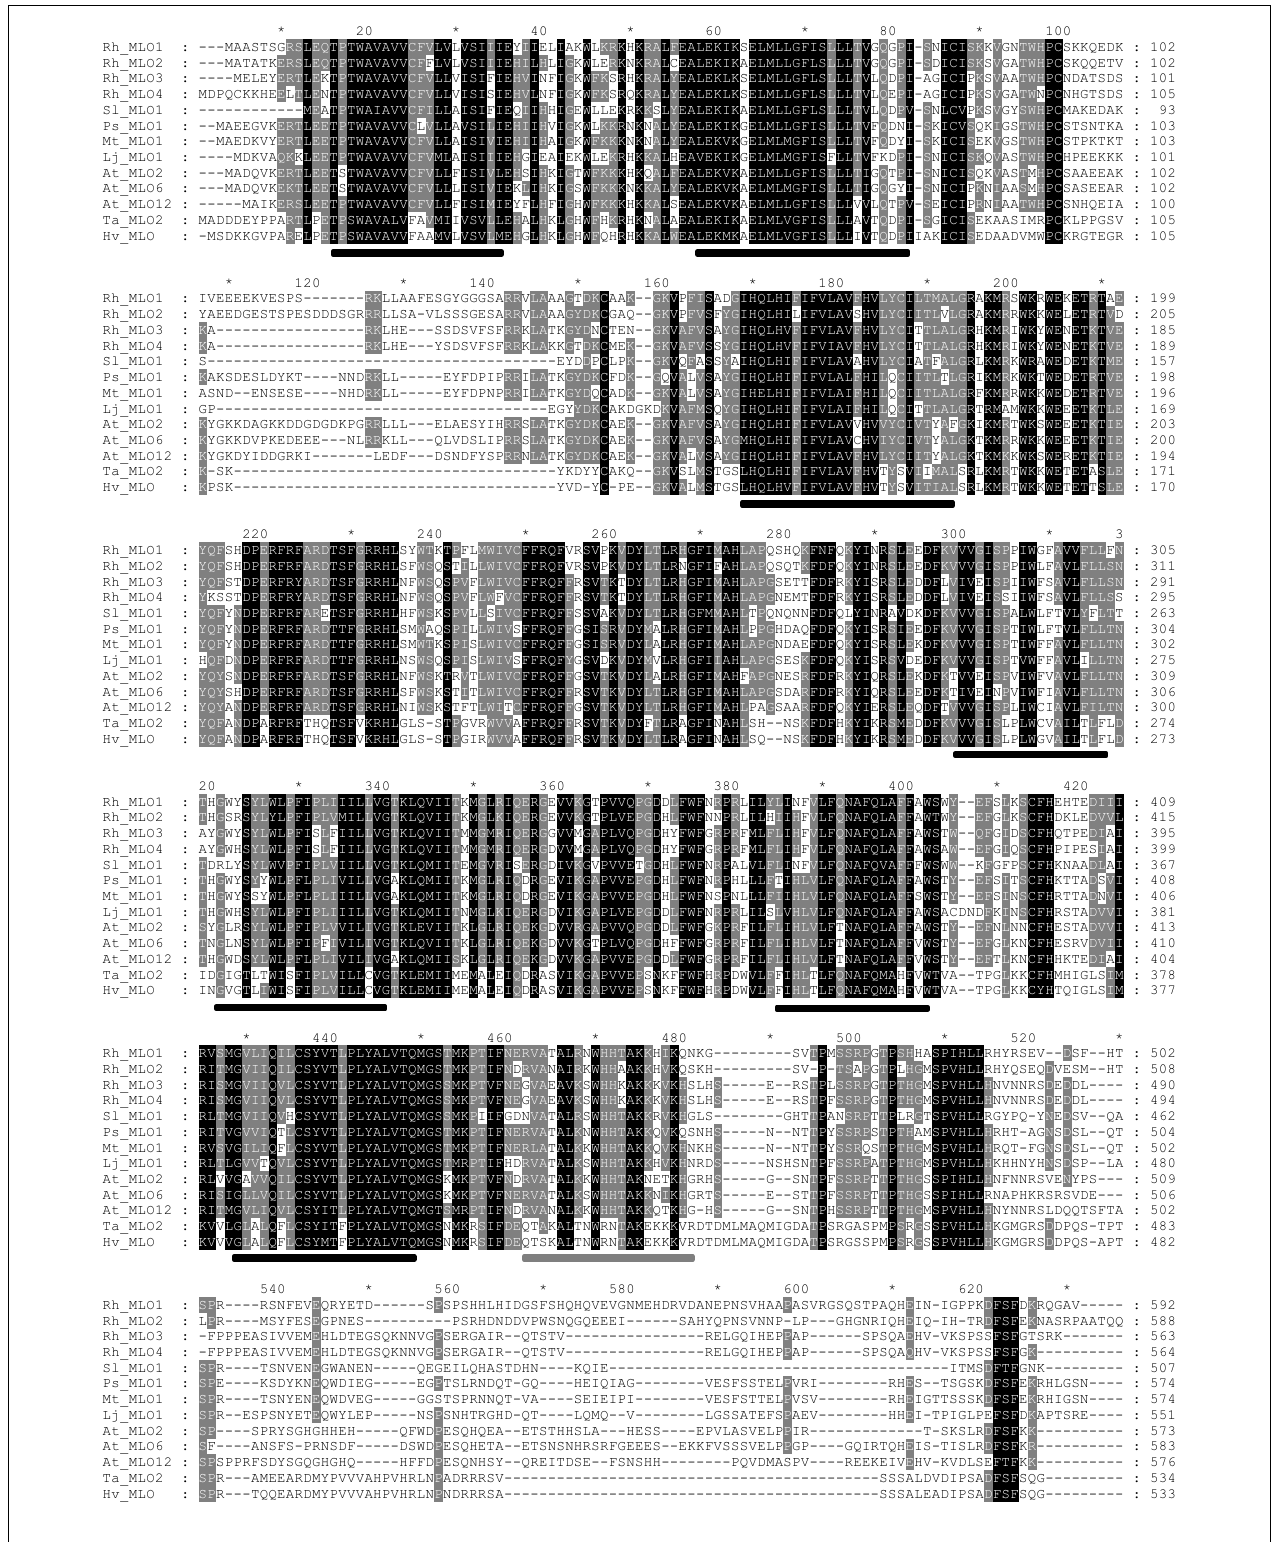
SPE----KSDYKNEQWDIEG-----EGPTSLRNDQT-GQ----HEIQIAG--------VESFSSTELPVRI--------RHES--TSGSKDFSFEKRHLGSN---- SPR----TSNYENEQWDVEG-----GGSTSPRNNQT-VA----SEIEIPI--------VESFSTTELPVSV--------RHEIGTTSSSKDFSFEKRHIGSN---- SPR--ESPSNYETEQWYLEP-----NSPSNHTRGHD-QT----LQMQ--V--------LGSSATEFSPAEV--------HHEI-TPIGLPEFSFDKAPTSRE---- SP----SPRYSGHGHHEH-----QFWDPESQHQEA--ETSTHHSLA---HESS----EPVLASVELPPIR-------------T-SKSLRDFSFKK---------- SF----ANSFS-PRNSDF-----DSWDPESQHETA--ETSNSNHRSRFGEEES--EKKFVSSSVELPPGP----GQIRTQHEIS-TISLRDFSFKR----------